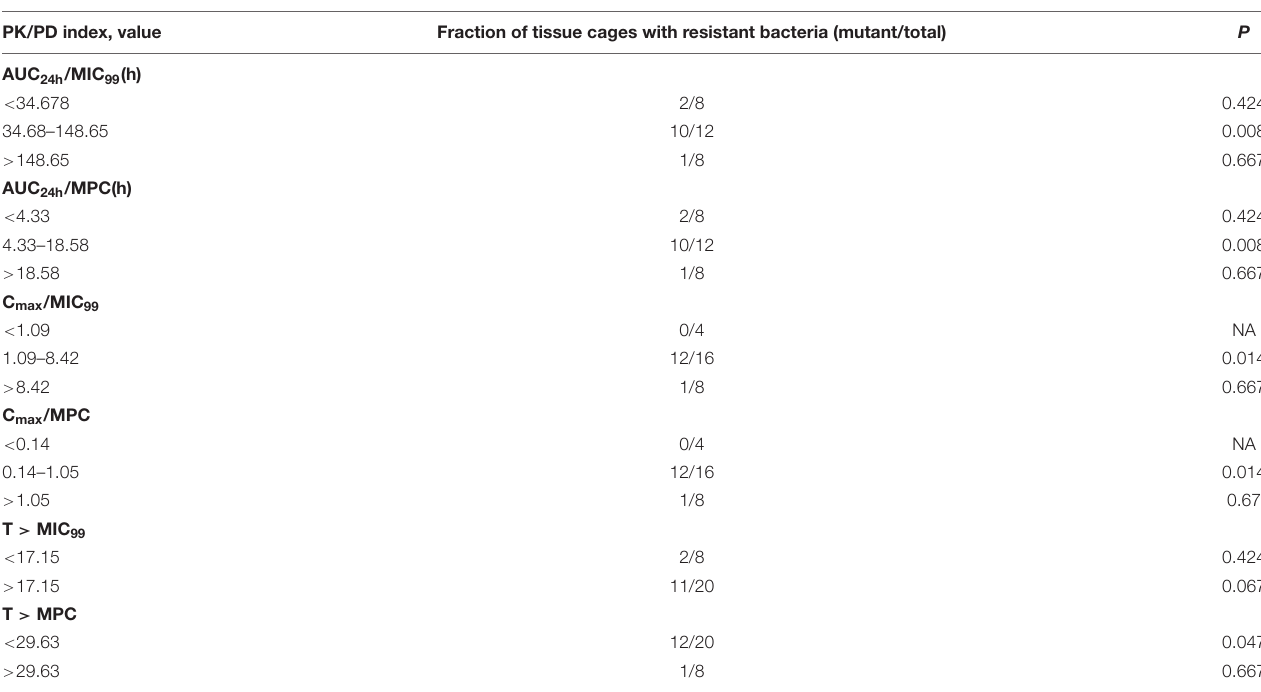
TABLE 3 | Correlation of PK/PD parameters with selection of resistance.